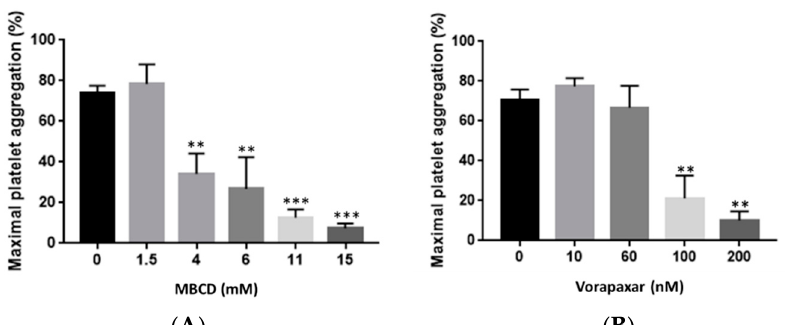
Figure 1. Effect of MBCD and vorapaxar on TRAP-activated washed platelets. ( A ) MBCD significantly decreased the maximal platelet aggregation induced by TRAP 25 µM. Results are mean ± SEM from three independent experiments. ** p < 0.01, *** p < 0.001 according to one-way ANOVA test. ( B ) Vorapaxar at 100 and 200 nM significantly decreased the maximal platelet aggregation induced by TRAP 25 µM. Results are mean ± SEM from three independent experiments. ** p < 0.01 according to one-way ANOVA test. MBCD: methyl β cyclodextrin.